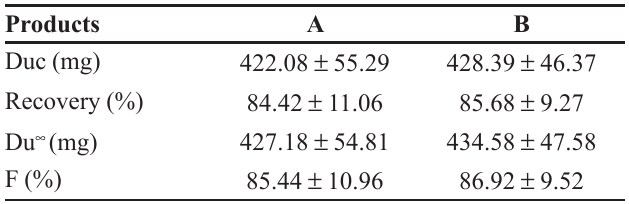
TABLE II - Mean of cumulative amount of cephalexin excreted ( Duc ), mean of total amount of cephalexin excreted ( Du ∞ ), mean of urinary recovery percentage of cephalexin and fraction of absorbed dose ( F ) after oral administration of immediate- release tablets (products A and B, n=24). Values represent mean